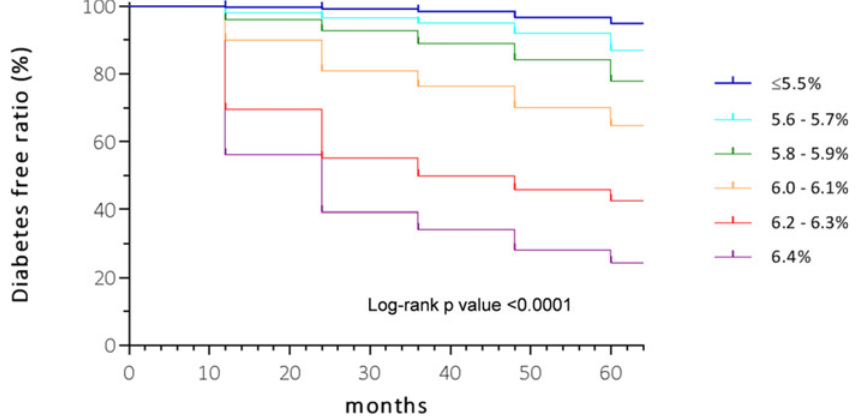
Fig 1. Kaplan — Meier survival curves for incident diabetes during the 5-year study period, differentiated by baseline HbA 1c levels. Each curve had a significantly higher risk compared with the reference group, the curve for HbA 1c (cid:1) 5.5% (log-rank P value < 0.0001).